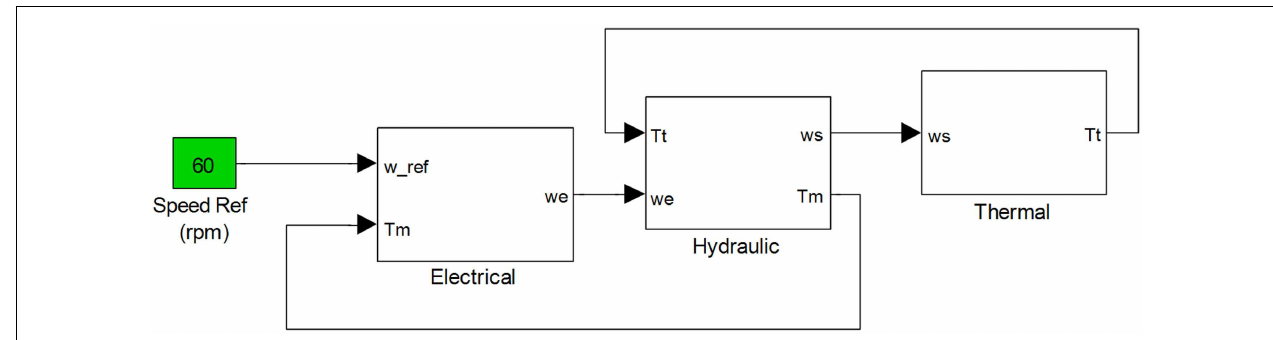
FIGURE 4 | Notional coupled electrical, hydraulic and thermal systems .